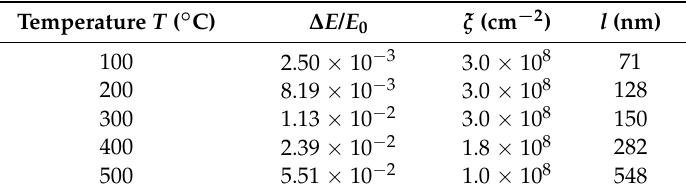
Table 1. AISI 304 steel submitted to the heating treatment with isothermal stages at increasing temperatures shown in Figure 1: the mean length l of dislocation segments has been calculated from dislocation density ξ measured by XRD and ∆ E/E values determined in the MS